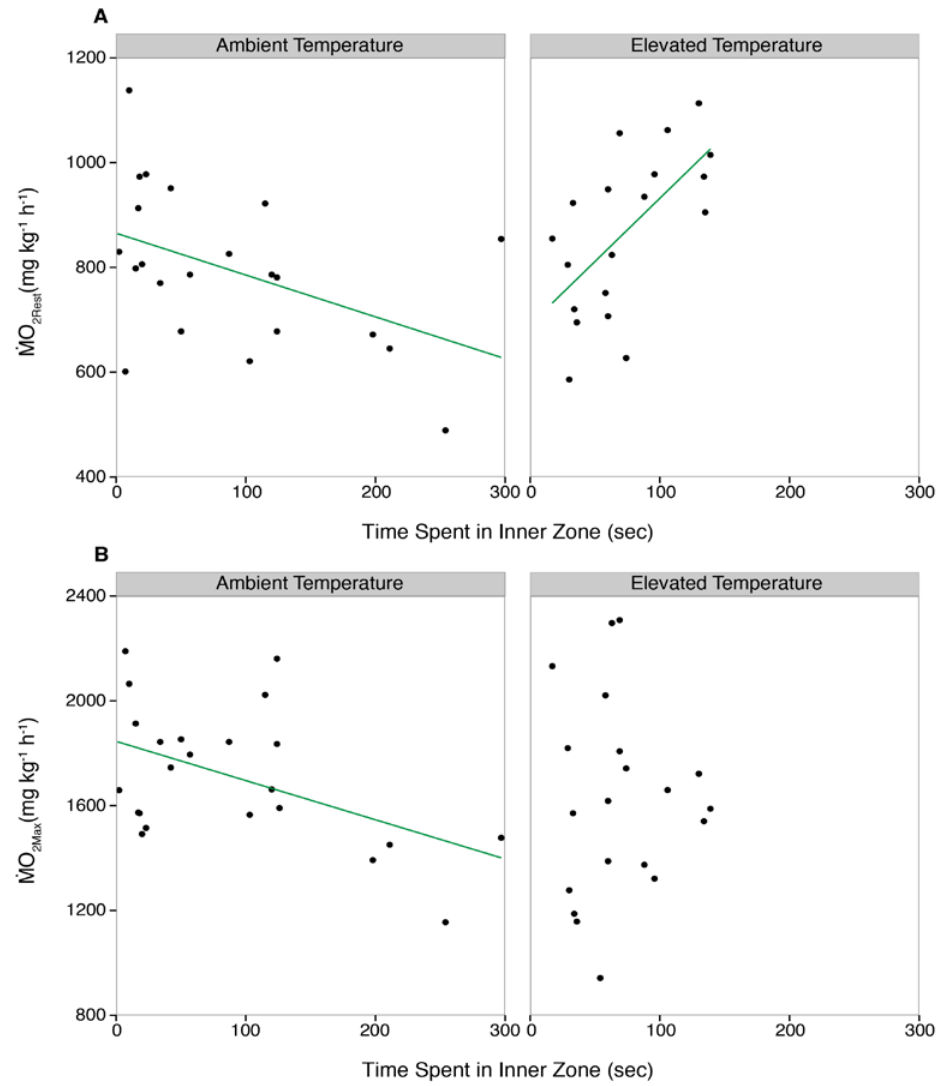
. O 2Rest and ( B ) M O 2Rest and . M O 2Max in larval yellowtail kingfish. Panels represent O 2Max in larval yellowtail kingfish. Panels represent 𝑀𝑀 ̇ 𝑀𝑀 ̇